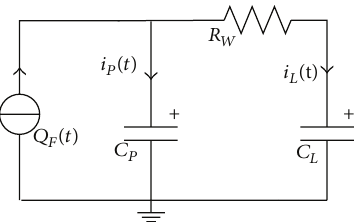
Figure 5: PVDF unit with capacitive